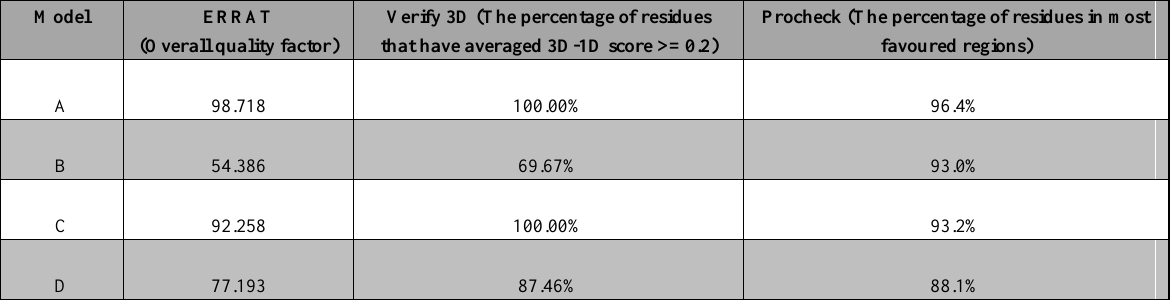
Table 3. The ERRAT, Verify3D, and Procheck server results compared 3D structures of Model A, Model B, Model C and Model D of uncharacterized protein